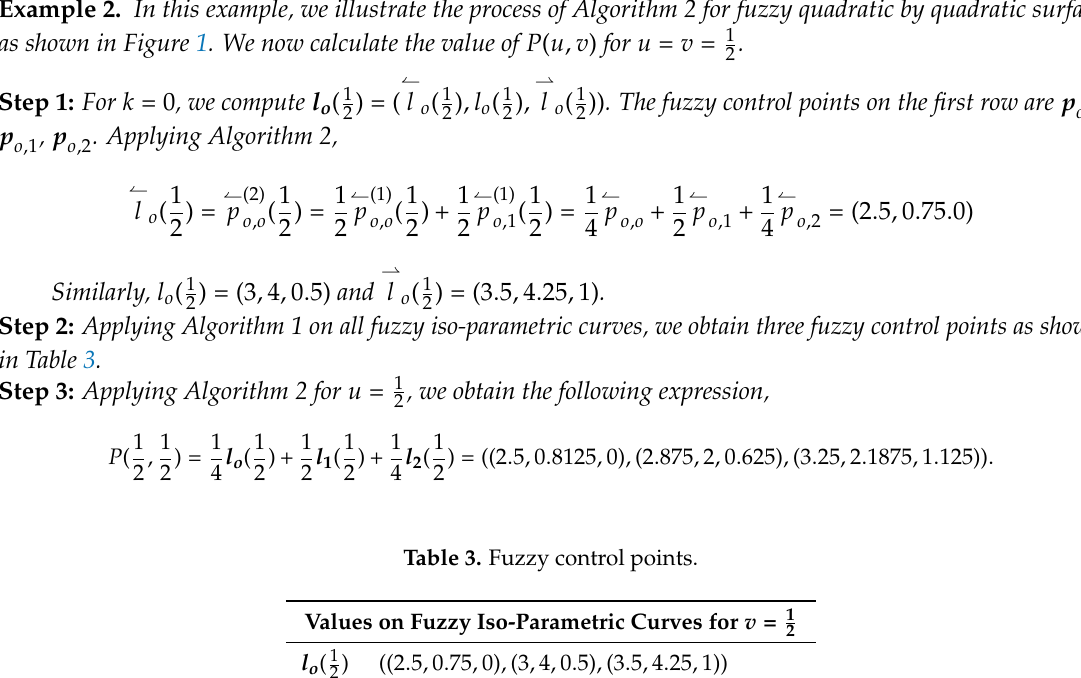
Algorithm 2. De Casteljau’s algorithm for fuzzy B.B surfaces